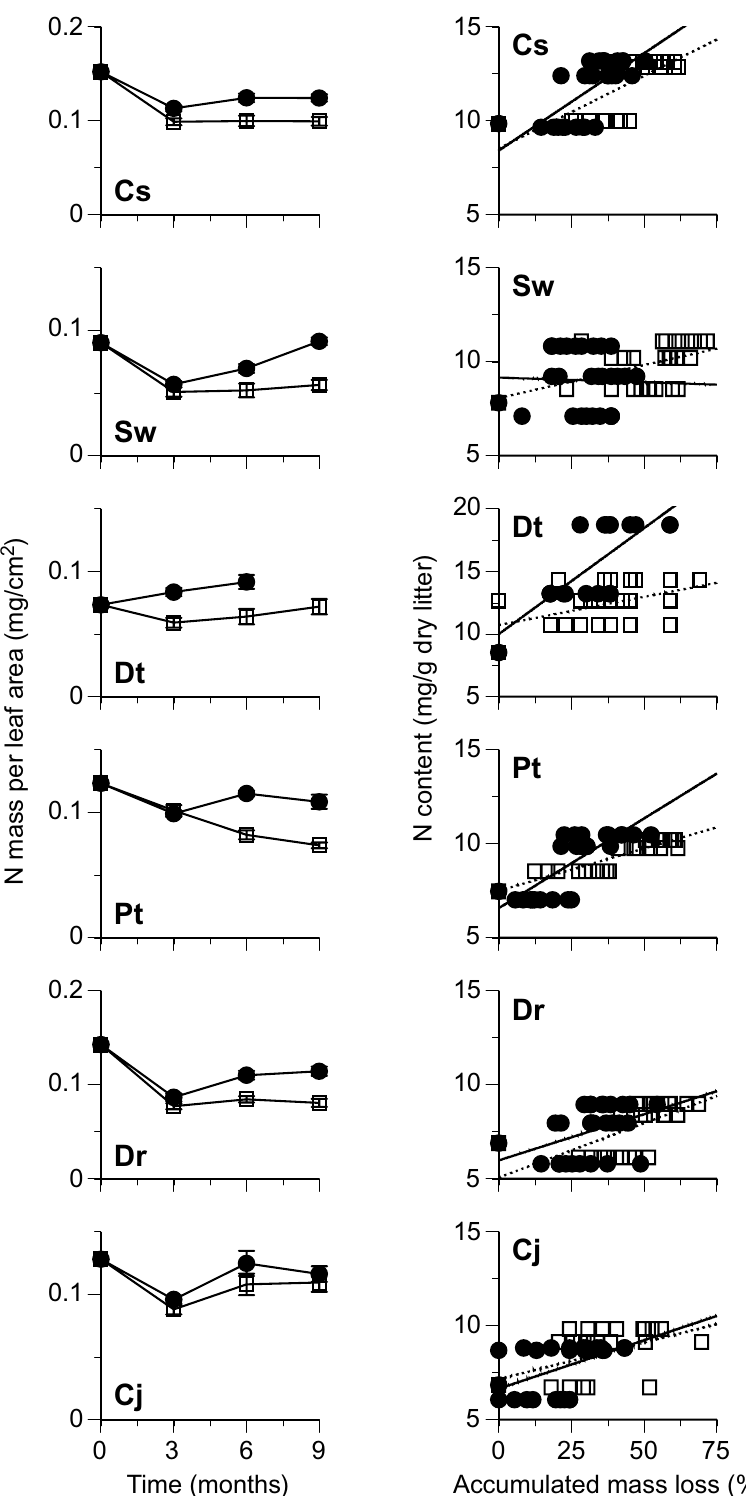
Figure 5. Changes in N mass per leaf area (left) and relationship between accumulated mass loss and N content (right) in bleached (open square, dotted line) and nonbleached portions (filled circle, black line) during decomposition. Codes on the panels indicate the first letter of genus and species names of tree species. Bars indicate standard errors. No data were available for total N content of the nonbleached portions of D. teijsmannii at 9 months of decomposition because of the small amount of